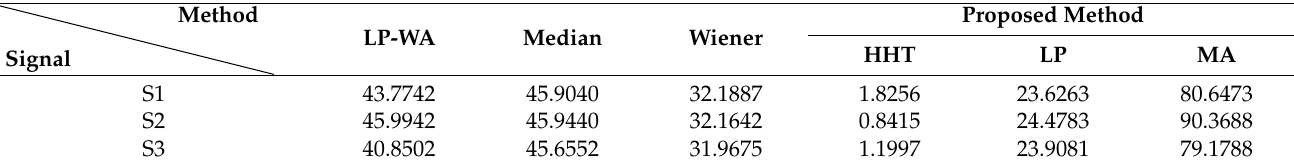
Table 1. SNR (dB) results by different signal processing